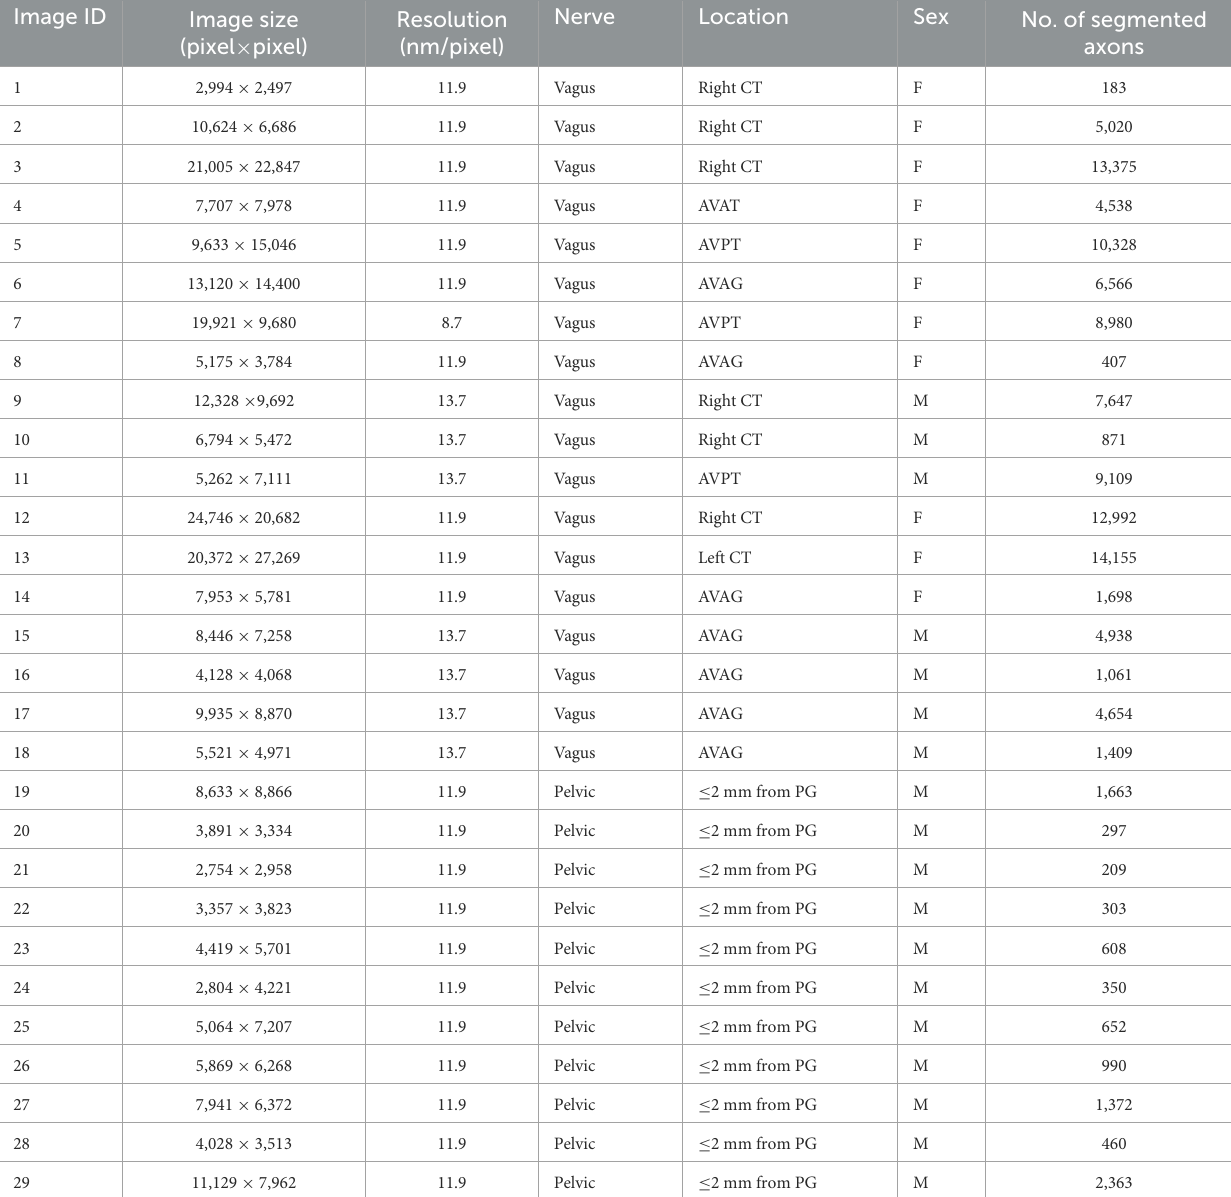
TABLE 1 The list of the TEM images of vagus and pelvic nerve cross-sections in rats used in this study. Image